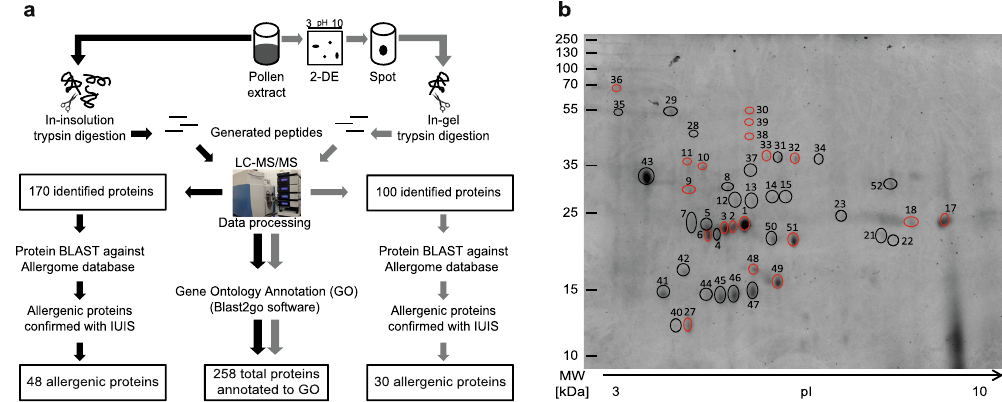
Figure 2. Proteomics of feverfew pollen reveals the presence of allergenic protein families. ( a ) Summarized workflow and results of the proteomic analyses. ( b ) Two-dimensional gel electrophoresis of feverfew pollen extract. After the isoelectric focusing, proteins were separated by SDS-PAGE and the spots were visualized by Coomassie staining. All excised spots subjected to mass analysis are circled and spots containing allergenic molecules are indicated in red circles. Detailed information of identified allergenic protein families is shown in Table 1. The unprocessed gel is shown in the Related Manuscript